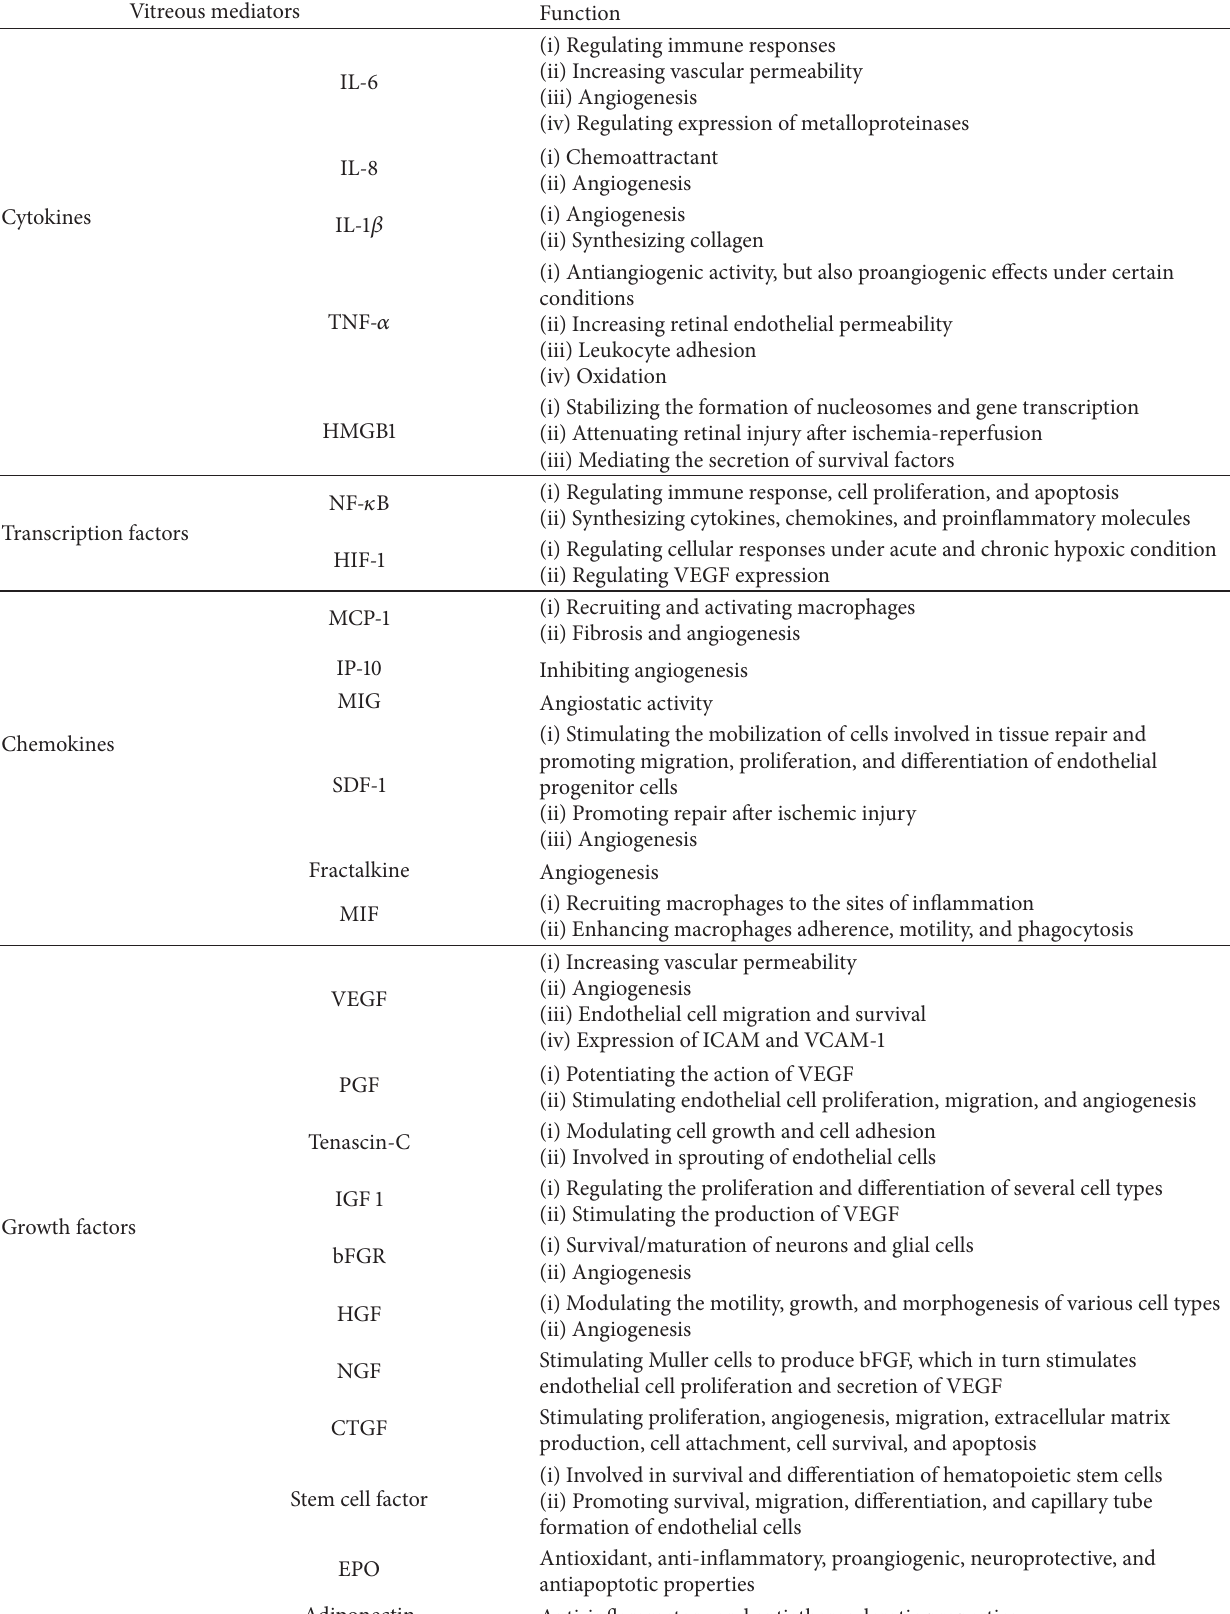
Table 2: Vitreous mediators involved in the pathogenesis of